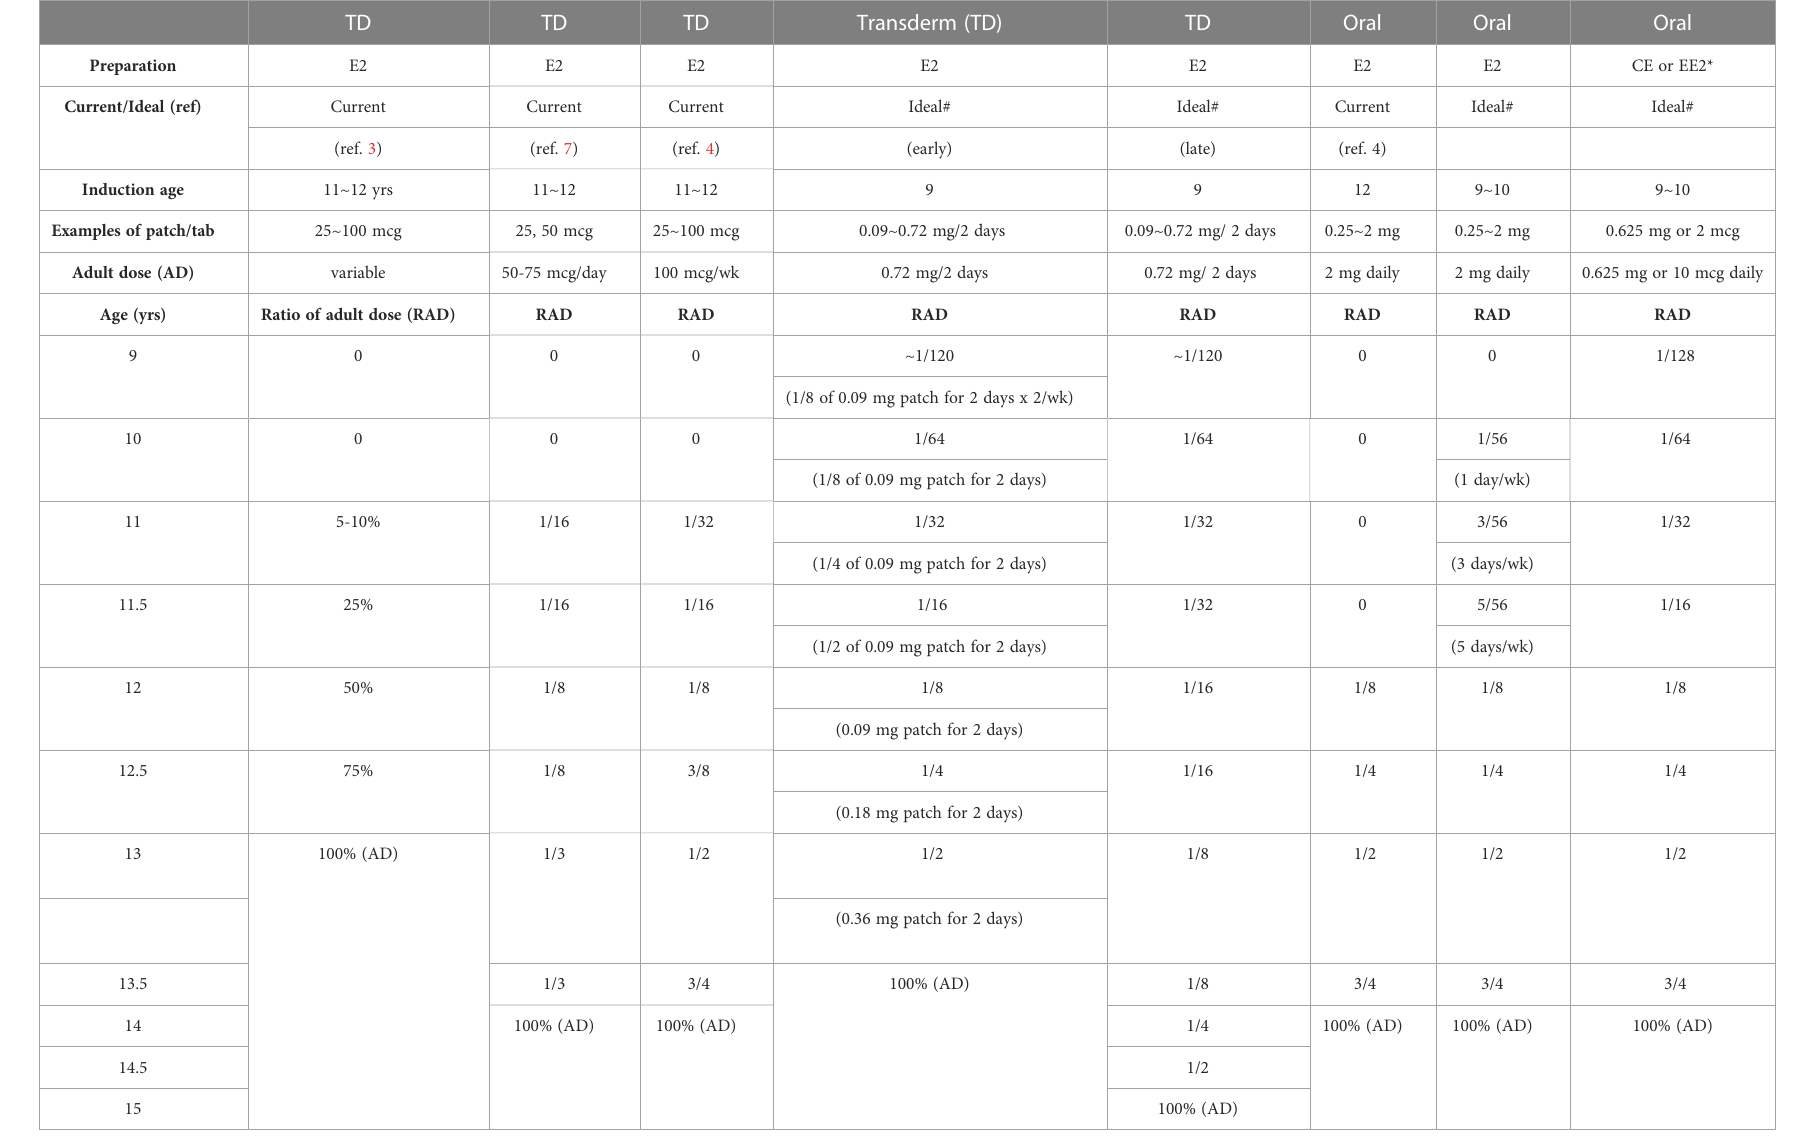
TABLE 7 Examples of dose escalation of Current and Ideal (earlier, lower-dosed)#, estrogen pubertal induction using estrogen in TS without endogenous